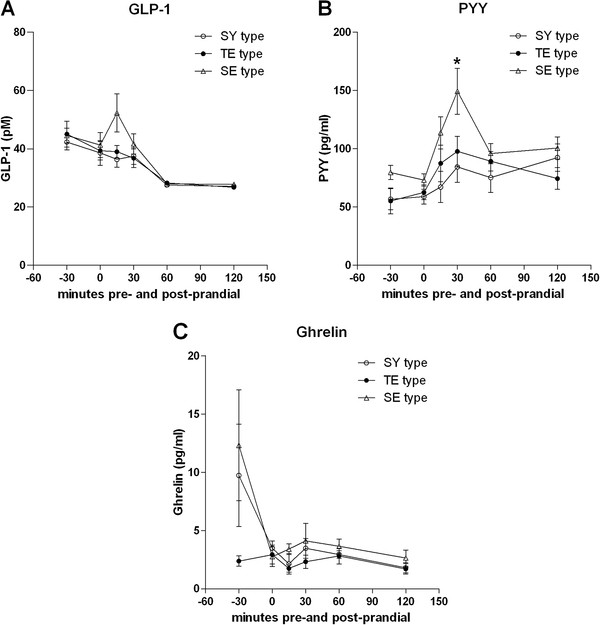
Pre- and post-prandial plasma levels of gut hormones across different Sasang constitutional types. Plotted in each figure are means and standard error of mean (SEM). (A) Glucagon-like peptide (GLP-1) (B) Peptide YY (PYY) (C) Ghrelin. Asterisk (*) denotes significant difference between different Sasang constitutional types at each time-point (p <0.017).